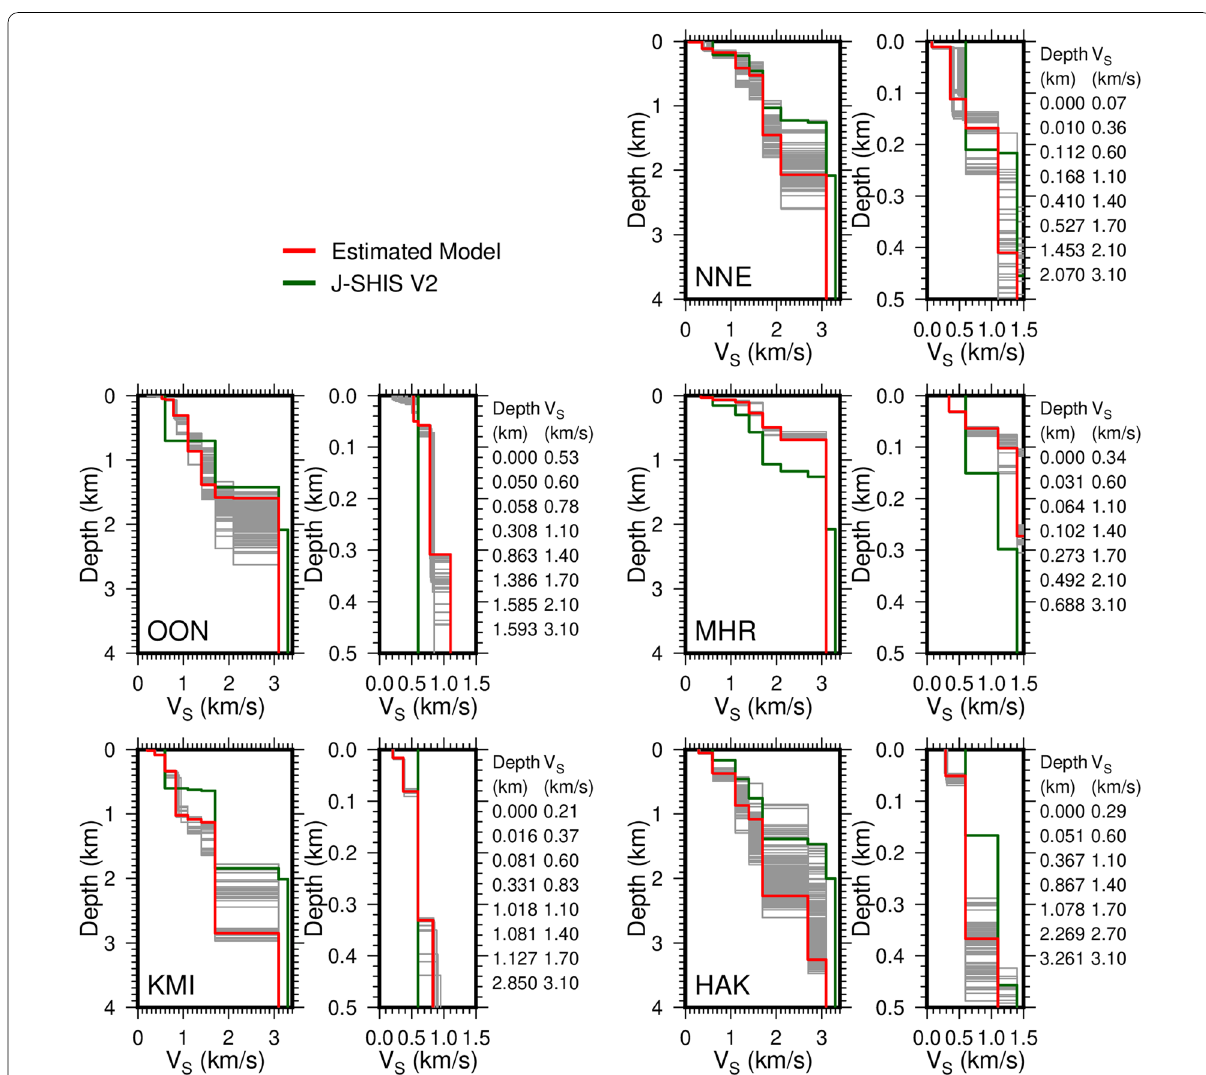
Fig. 3 S-wave velocity structure model at each surveyed site. Red line and green line indicate the estimated model in this study and the J-SHIS V2 model (Fujiwara et al. 2012), respectively. The left panel shows the S-wave velocity model for the whole part of sedimentary layers above the bedrock, and the right panel is its enlarged one to show the near-surface portion of the velocity